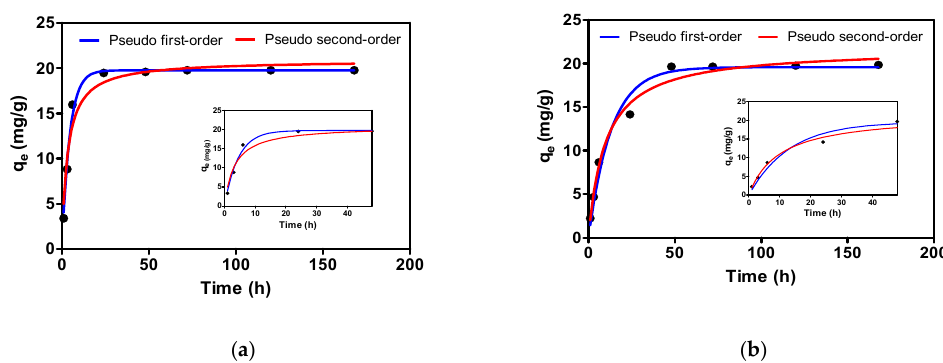
Figure 3. Arsenic adsorption kinetics. ( a ) MIRESORB TM ; ( b ) GFH. The initial arsenic (V) (As(V)) concentration was 30 mg/L, the adsorbent dose was 1 g/L, the pH was 6.0, and the contact times were 1, 3, 6, and 24 h and 2, 3, 5, and 7 d. Table 3. Kinetic parameters for As(V) adsorption by MIRESORB TM and GFH materials. Adsorbent